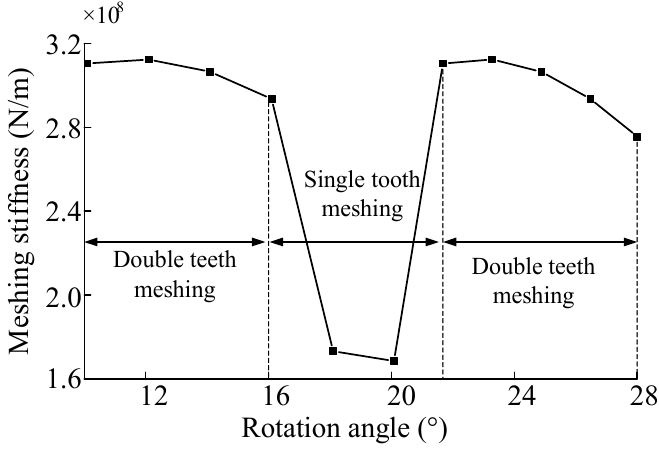
Figure 4. Meshing stiffness under normal conditions.